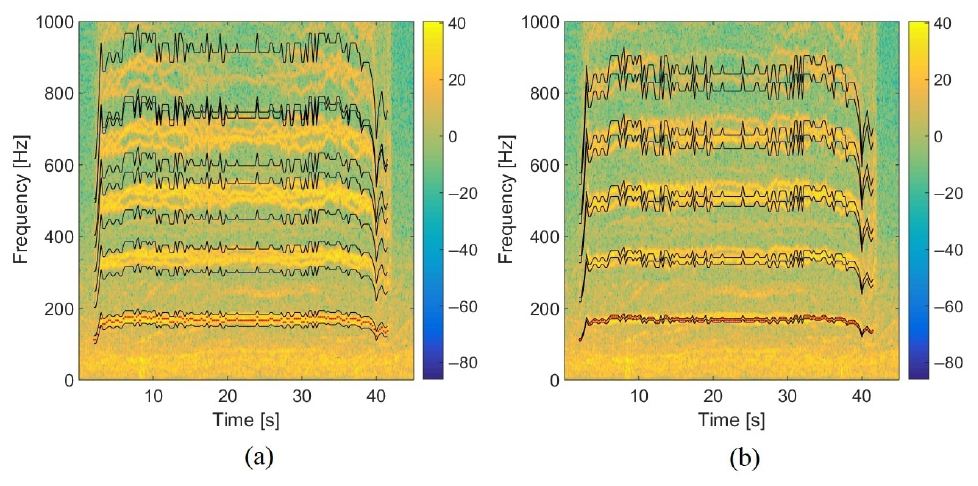
Figure 14. Spectrogram of the experimental trajectory with the selected content in the TFR for ( a ) Q = 5 and ( b ) Q = 17.5 (the red points are the estimated blade passing frequencies detected by SHC).